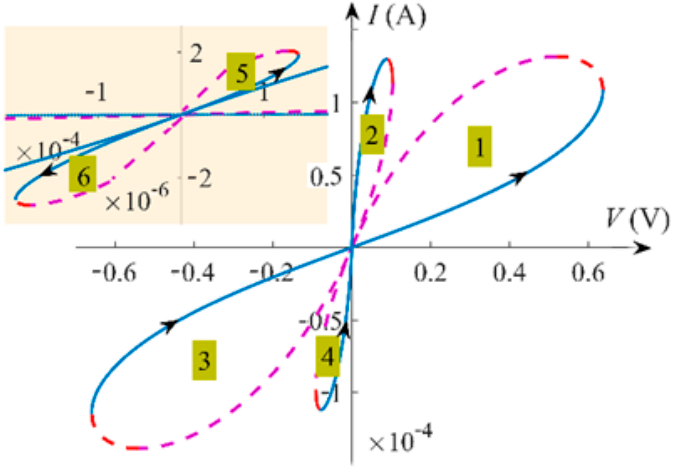
Figure 3. DC V – I curve of the memristor. Figure 3 . DC V – I curve of the memristor .